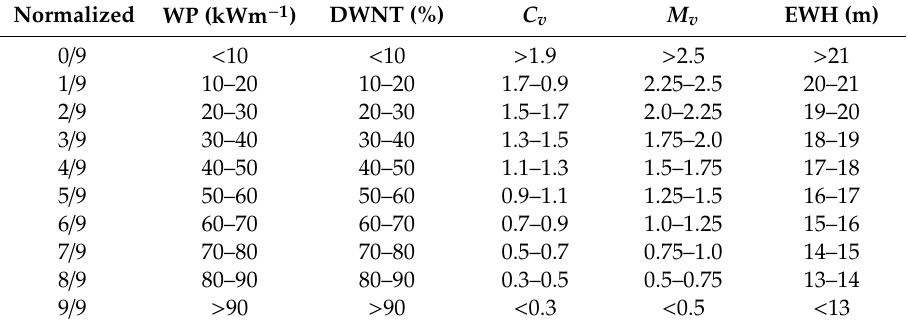
Table 5. Normalization criterion used for wave energy resource (WP), DWNT, C v , M v , and extreme wave heights (EWH) indices related to richness factors, variability factors, environmental risk factors, and cost